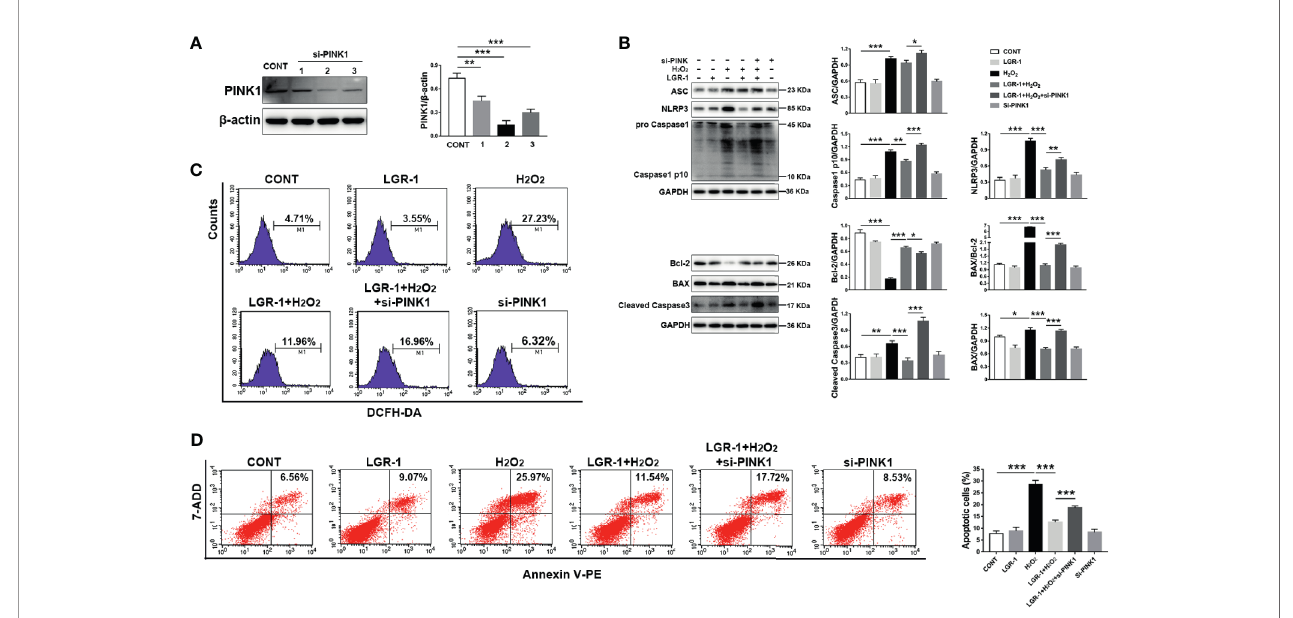
FIGURE 8 | Silencing PINK1 blocks the inhibitory effect of LGR-1 on Escherichia coli- induced ROS release, NLRP3 in fl ammasome activation, and apoptosis in MAC-T cells. (A) Western blot analysis of PINK1 in MAC-T cells after PINK1silencing (si-PINK1). The right panel shows the protein quanti fi cation using ImageJ software (version 1.50). (B) Western blot analysis ASC, NLRP3, Caspase-1, BAX, Bcl-2, and Caspase-3 in MAC-T cells after PINK1silencing (si-PINK1). The right panel shows the protein quanti fi cation using ImageJ software (version 1.50). (C) Flow cytometry analysis of ROS. M1 represents the proportion of cells stained with DCFH-DA. (D) Flow cytometry analysis of the percentage of apoptotic cells. The si-PINK1-MAC-T cells pretreated with LGR-1 for 3 h and then exposed to hydrogen peroxide (H 2 O 2 , ROS inducer; 0.5 mM) for 0.5 (h) Data presented are mean ± SEM; n = 3. * p < 0.05, ** p < 0.01, *** p <